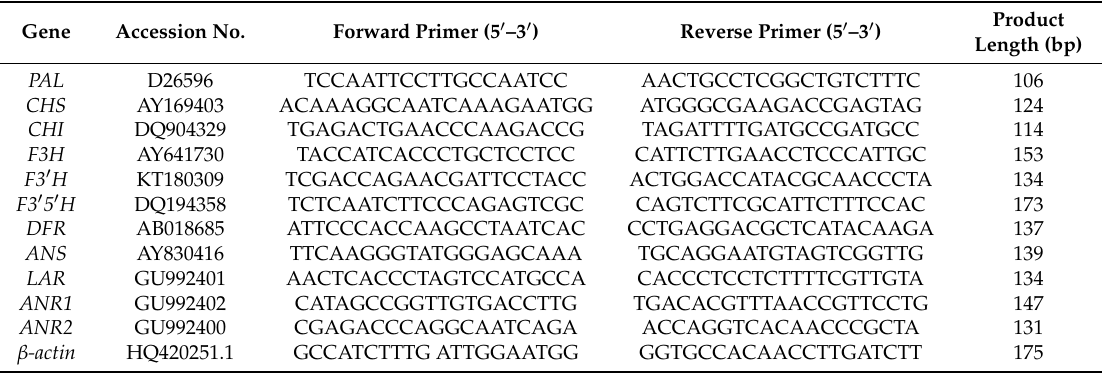
Table 3. Primers for Real time